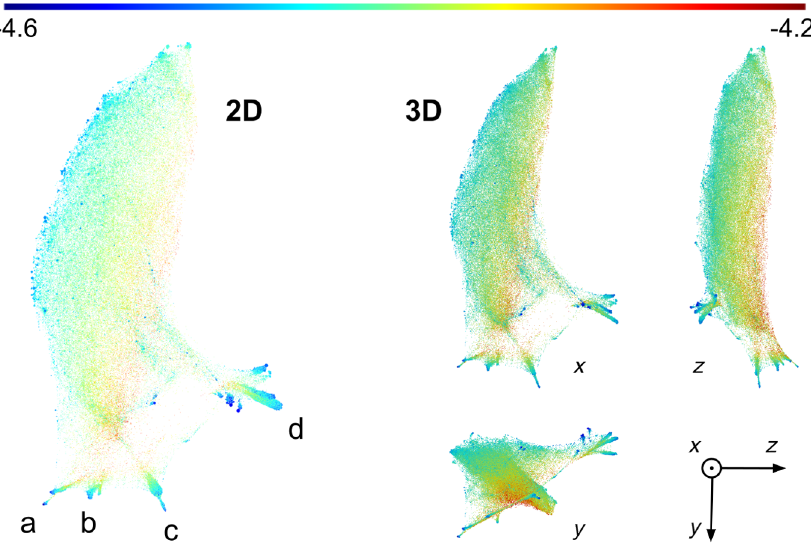
FIG. 9. 2D and 3D SHEAP maps produced from the same set of LJ 38 minima that are presented in Fig. 6, described using SOAP with 10 . 0 σ 15 , l 9 , and σ ¼ 0 . 3 σ parameters r , n . The projections use a perplexity of 30, with a minimum sphere radius cut ¼ LJ max ¼ max ¼ LJ R 0 . 006 for the 2D map and R 0 . 01 for 3D. The circles and spheres representing each structure are colored according to energy 0 ¼ 0 ¼ per atom in Lennard-Jones units; see the color bar at the top of the figure. Basin volumes are represented by the area (volume) of each circle (sphere). Each viewpoint of 3D map looks down one of the axes displayed, as labeled; the axes have no other physical meaning. (a) – (d) in the 2D map label proposed funnels in the LJ 38 PES, analogous to those labeled in Fig. 6, with the same low-energy minima residing at the